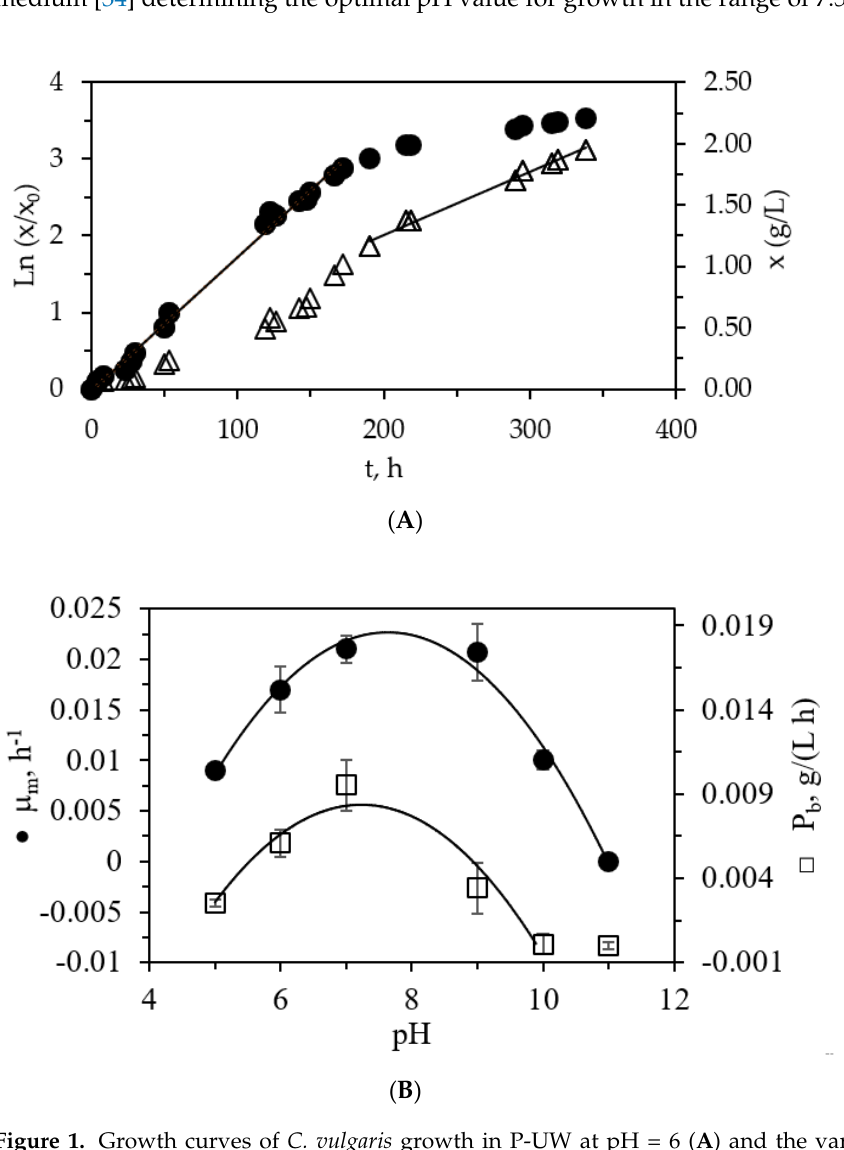
Figure 1. Growth curves of C. vulgaris growth in P-UW at pH = 6 ( A ) and the variation of the maximum specific growth rates and volumetric biomass productivities versus the pH value of the culture media ( B ). Common operating conditions: P-UW, aeration rate 0.5 L/min, mechanical stirring 200 rpm, illumination intensity 359 µE/(m 2 s) and temperature 25 °C. The error bars corresponding to the standard deviation.